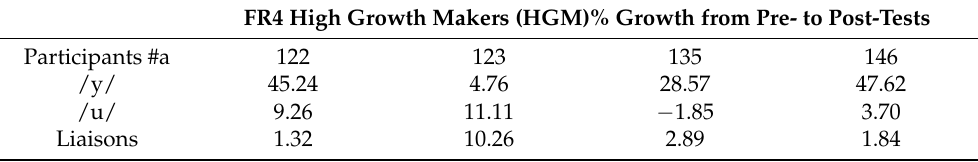
Table 9. Participants’ pronunciation growth from pre–post-tests in